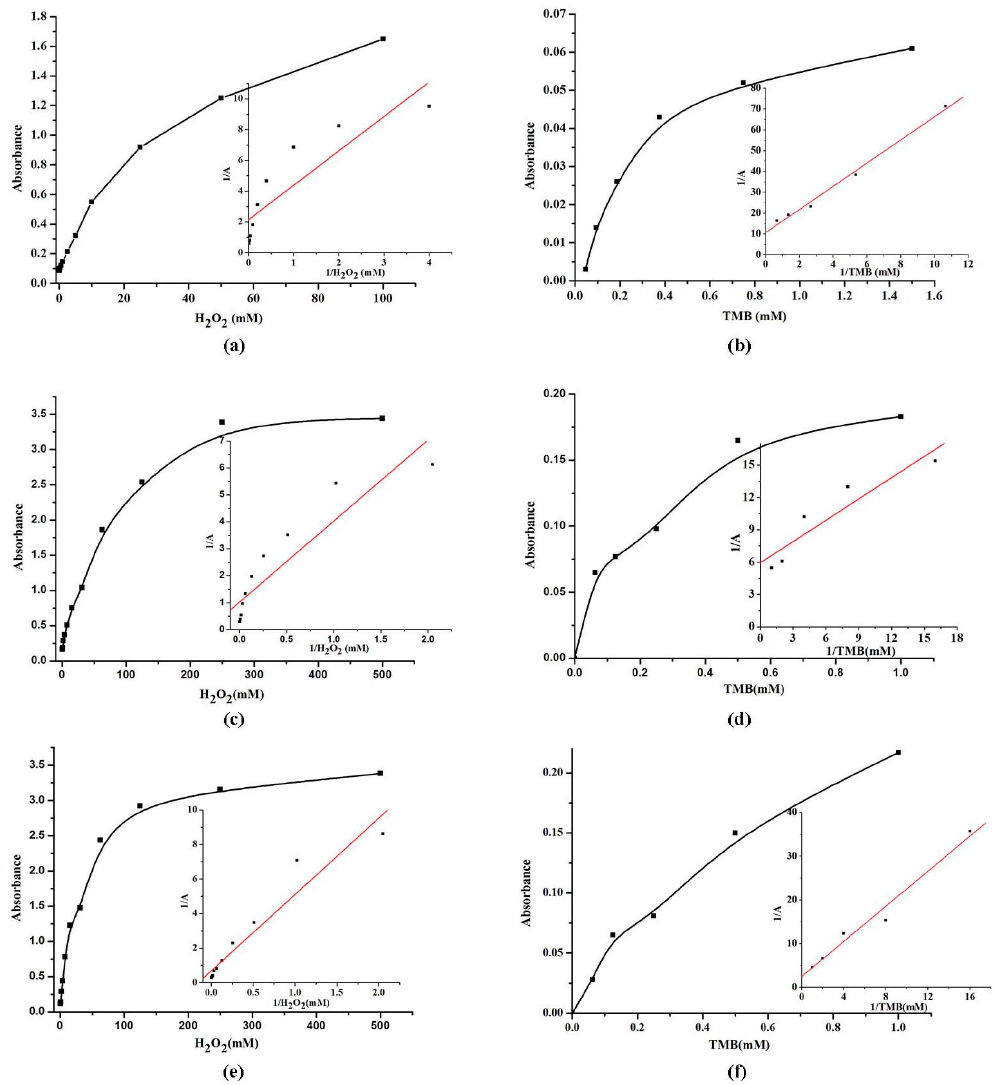
Figure 7. The steady-state kinetic assay and catalytic mechanism of VO 2 nanofibers ( a , b ); VO 2 nanosheets ( c , d ); and VO 2 nanorods ( e , f ) as peroxidase mimics. Conditions: pH, 4.0 (0.2 M citrate buffer); temperature, 25 °C; incubation time, 5 min.